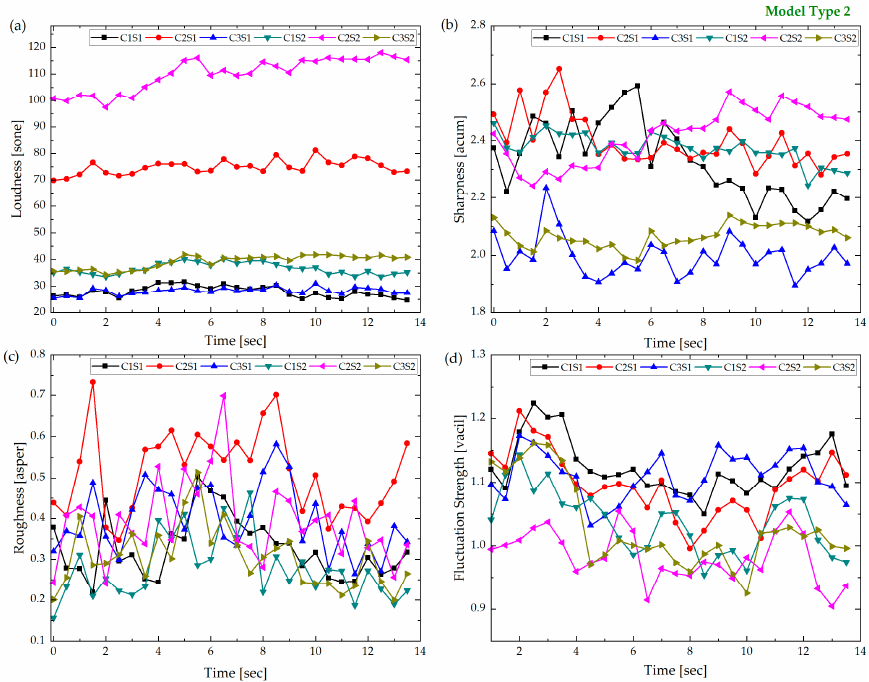
Figure 4. Psychoacoustic parametric values for the vacuum cleaner (model type 2). ( a ) Loudness, ( b ) sharpness, ( c ) roughness, and ( d ) fluctuation strength.